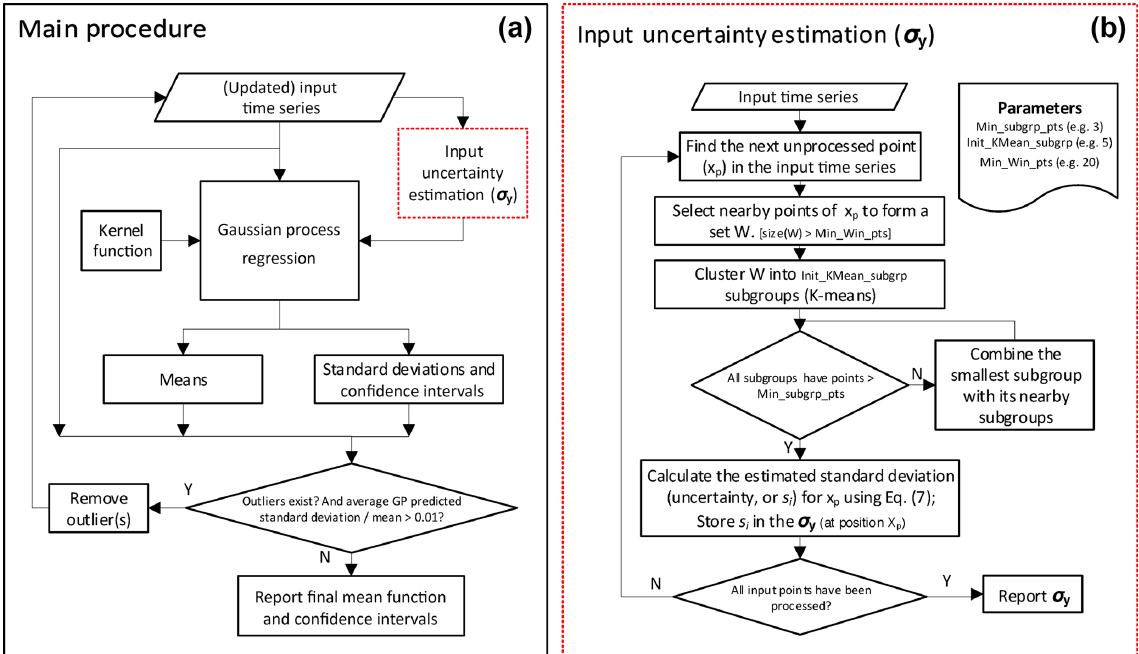
Figure 1. Main procedure for deriving the mean and confidence interval functions using Gaussian process regression (a) and detailed procedure of the proposed input uncertainty estimation method (b)